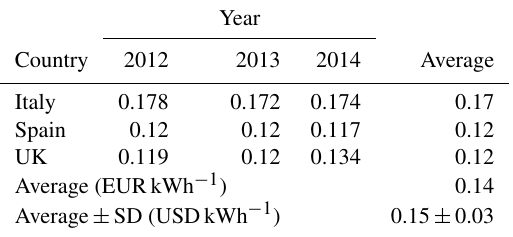
Table F1. Cost of energy, Eurostat (2016).